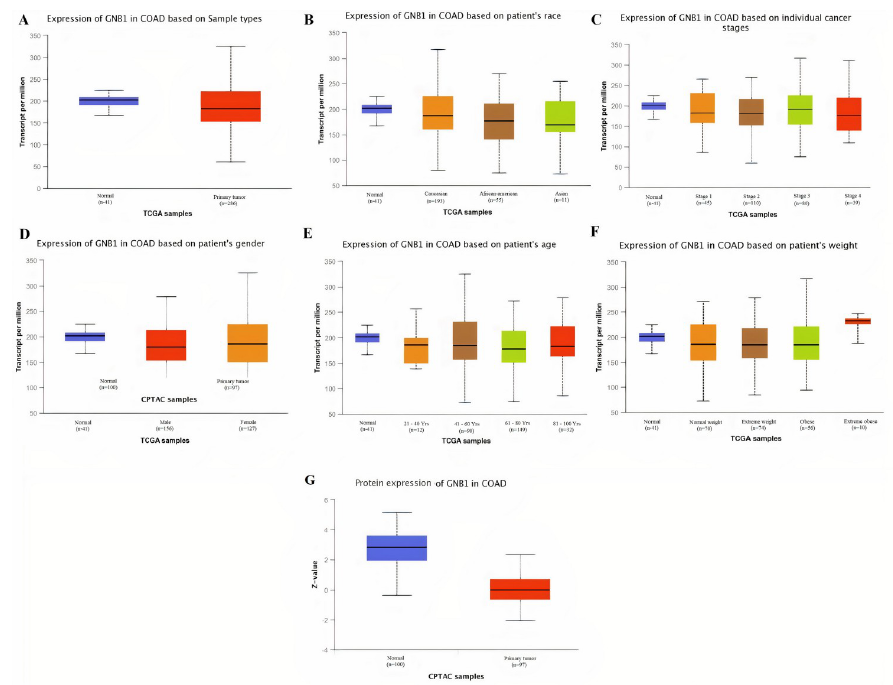
Fig 8. Box plots showing the relative expression levels of GNB1 in normal and COAD samples of different clinicopathological features via UALCAN database. Relative mRNA expression of GNB1: (A) in normal individuals and COAD patients; (B) in normal individuals and COAD patients of different races; (C) in normal individuals and COAD patients of different cancer stages; (D) in normal individuals and COAD patients of different genders; (E) in normal individuals and COAD patients of different age groups; and, (F) in normal individuals and COAD patients of different body weights; (G) Relative protein expression of GNB1 in normal individuals and COAD patients. A p-value of < 0.05 was considered significant. Normal weight = BMI greater than or equal to 18.5 and BMI less than 25, Extereme weight = BMI greater than or equal to 25 and BMI less than 30, Obese = BMI greater than or equal to 30 and BMI less than 40, and Extreme Obese = BMI greater than